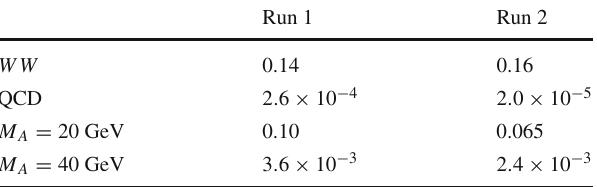
Table 1 Efficiencies of R → SS and Z (cid:8) → WW signals and the QCD dijet background for the W Z selection in ATLAS hadronic diboson searches